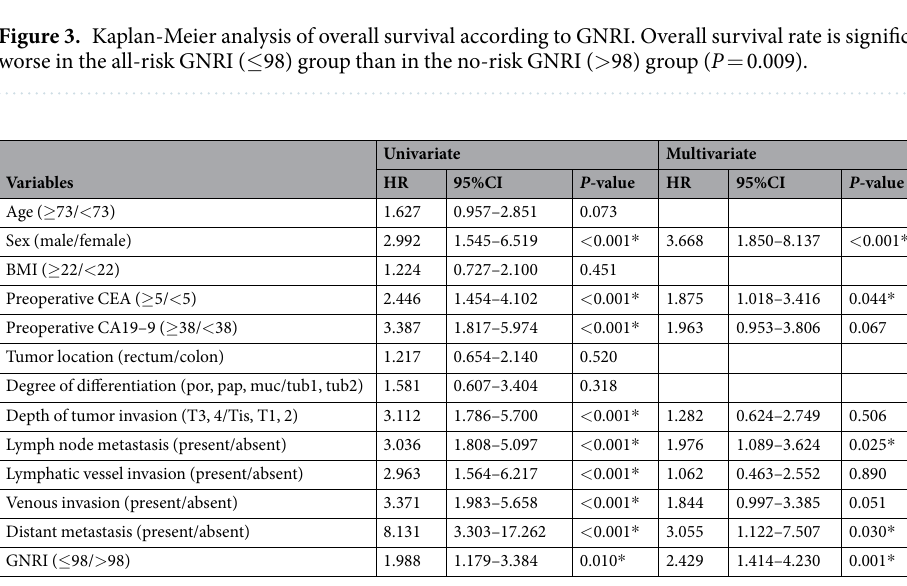
Table 5. The univariate and multivariate analyses of prognostic factors for overall survival. HR = hazard ratio, CI = confidence interval, BMI = body mass index, CEA = carcinoembryonic antigen, CA19–9 = carbohydrate antigen 19–9, por = poorly differentiated adenocarcinoma, pap = papillary adenocarcinoma, muc = mucinous adenocarcinoma, tub1 = well differentiated adenocarcinoma, tub2 = moderately differentiated adenocarcinoma, GNRI = geriatric nutritional risk index, Asterisk values indicate P -values <